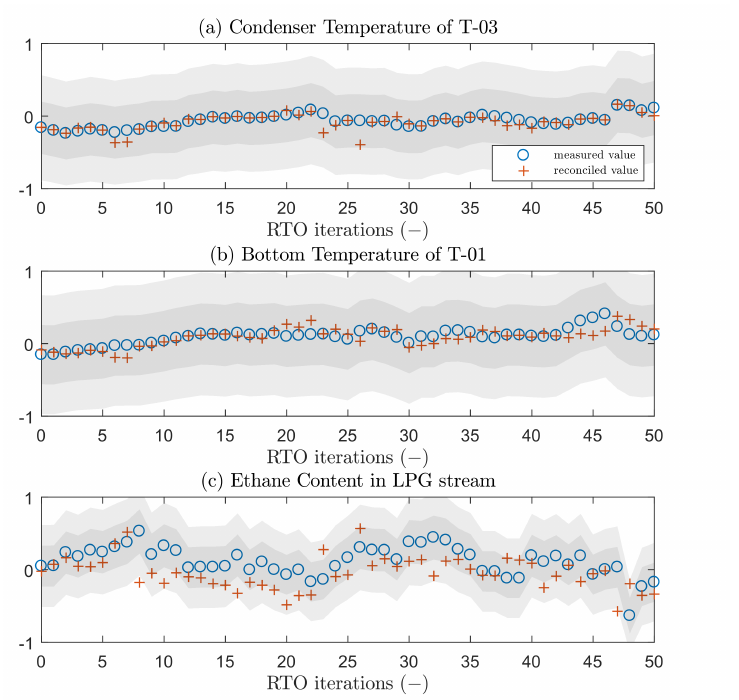
Figure 5. Data reconciliation results: ( a ) condenser temperature of T-03; ( b ) bottom temperature of T-01; ( c ) ethane content in LPG stream.